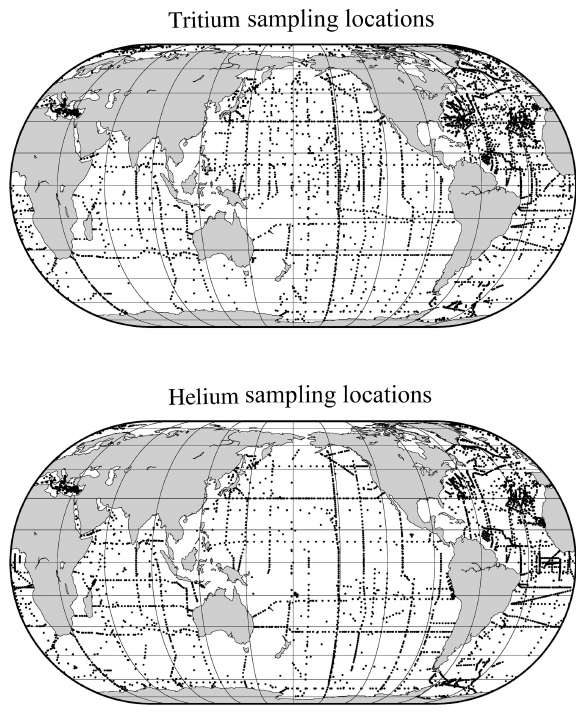
Figure 3. Tritium and helium sample